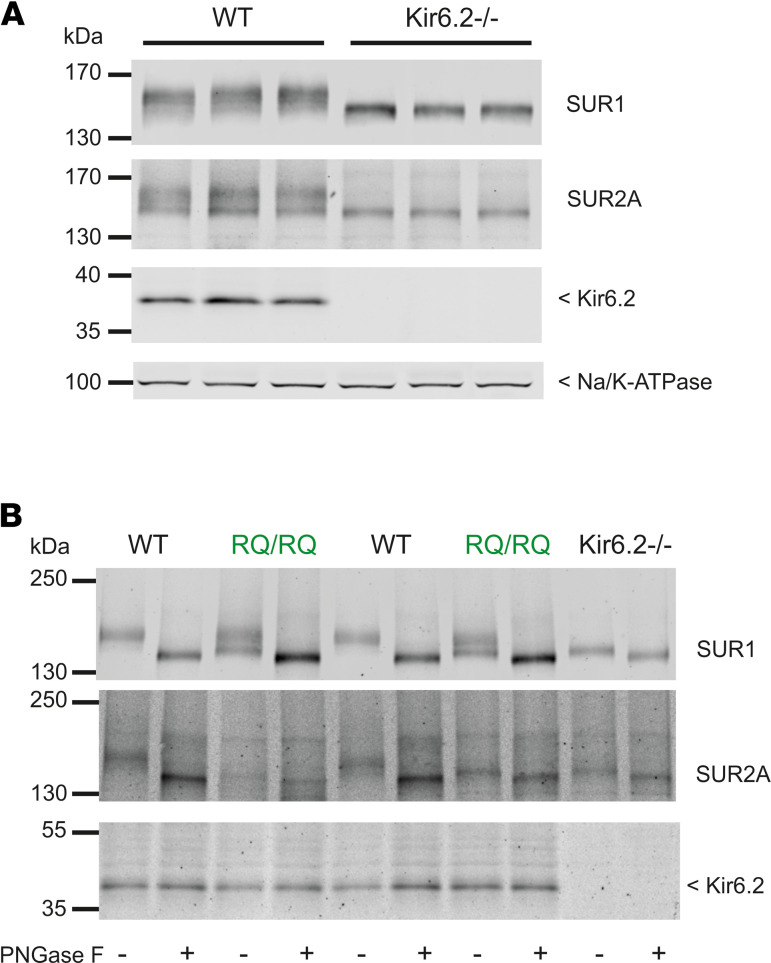
SUR1 and SUR2A maturation in SUR2A[R1154Q] hearts.(A) Western blot analysis of the membrane fraction from ventricular heart tissue of WT and Kir6.2–/– mice. Representative result from 3 biological replicates. (B) PNGase F treatment (18.75 U/μL) of ventricular heart membrane lysates of WT, SUR2WT/RQ, SUR2RQ/RQ, and Kir6.2–/– mice. Representative Western blot of 2 biological replicates.